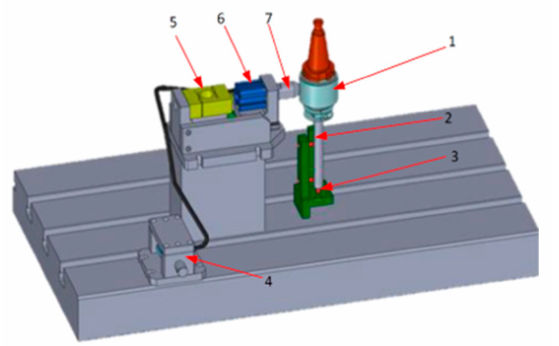
Figure 59. The experimental unit used to apply test load during spindle errors measurements: the external force acts over a precise ball bearing ( 1 ). The force of the load unit ( 6 ) can be controlled through the pressure exciter ( 4 ). The load unit is directly linked with a tensor unit ( 5 ) and a contact pin ( 7 ). Displacement in the X, Y, and Z axes is measured on a high precision double-ball artefact ( 2 ) by proximity sensors ( 3 ) [43]